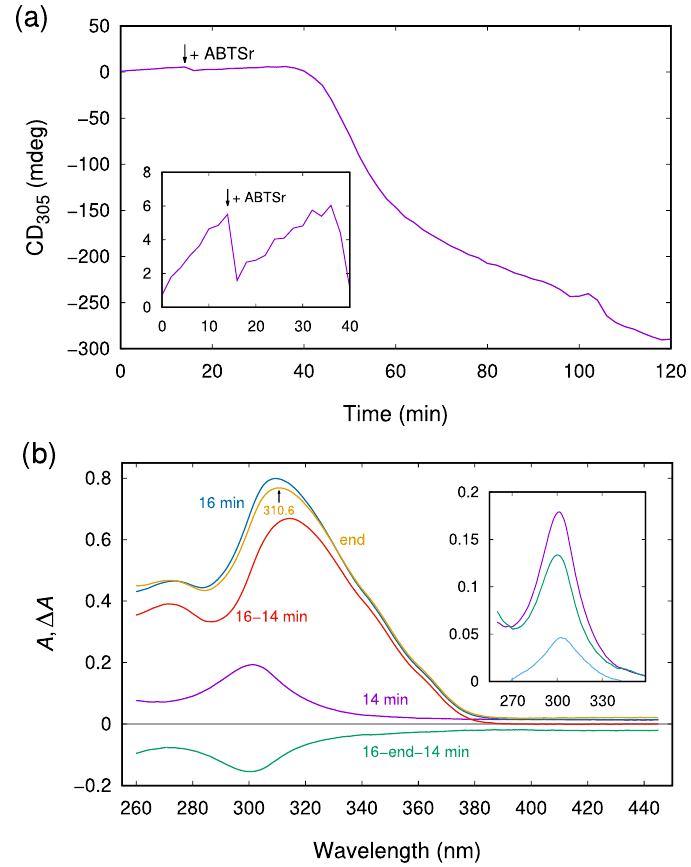
Figure 8. CD and UV/Vis spectrophotometric analysis of the effect of ABTSr addition (at 14 min) during the reaction of 300 µ M Cu 2+ with 300 µ M NAC in 40 mM HClO 4 at 20 ◦ C. The spectra (445 → 260 nm, resolution 0.1 nm) are scanned in 2 min cycles at a rate of 100 nm min − 1 . ( a ) A time record of the ellipticity at 305 nm; 20 µ M of ABTSr is added at 14 min (arrow) from the beginning of the reaction. ( b ) UV/Vis spectra plotted as absorbance ( A ) and difference absorbance ( ∆ A ) vs. wavelength. Details are explained in the